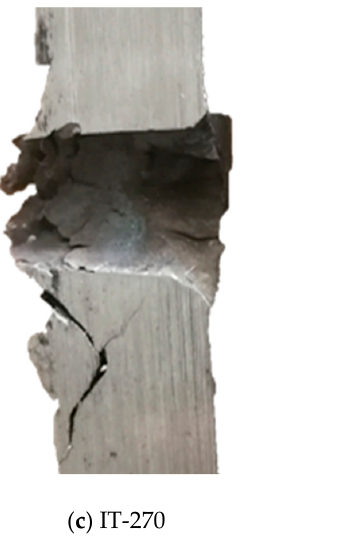
Figure 8. Cross-sectional images of the holes on the ballistic test samples: ( a ) IT-360, ( b ) IT-320, ( c ) IT-270, ( d ) RHA, ( e ) IT-320-T, and ( f ) IT-270-T.